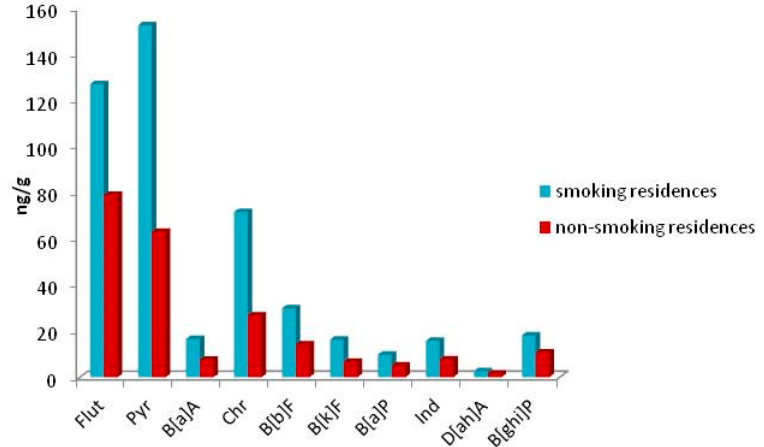
Figure 2. Concentrations of COMPAHs in smoking and nonsmoking houses.